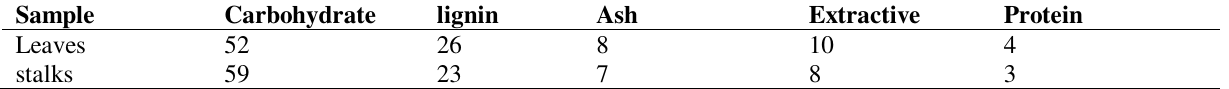
The composition of date palm fronds (leaves and stalk) based on dry weight wt/wt Sample Carbohydrate Leaves